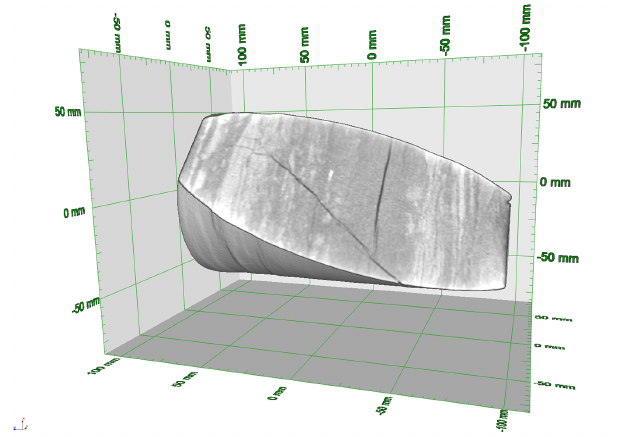
Figure 6. Partial 3-D view of the speed scan CT result. Within the virtual core, the layered structure (due to changes in the mineralog- ical composition) and two main cracks can be